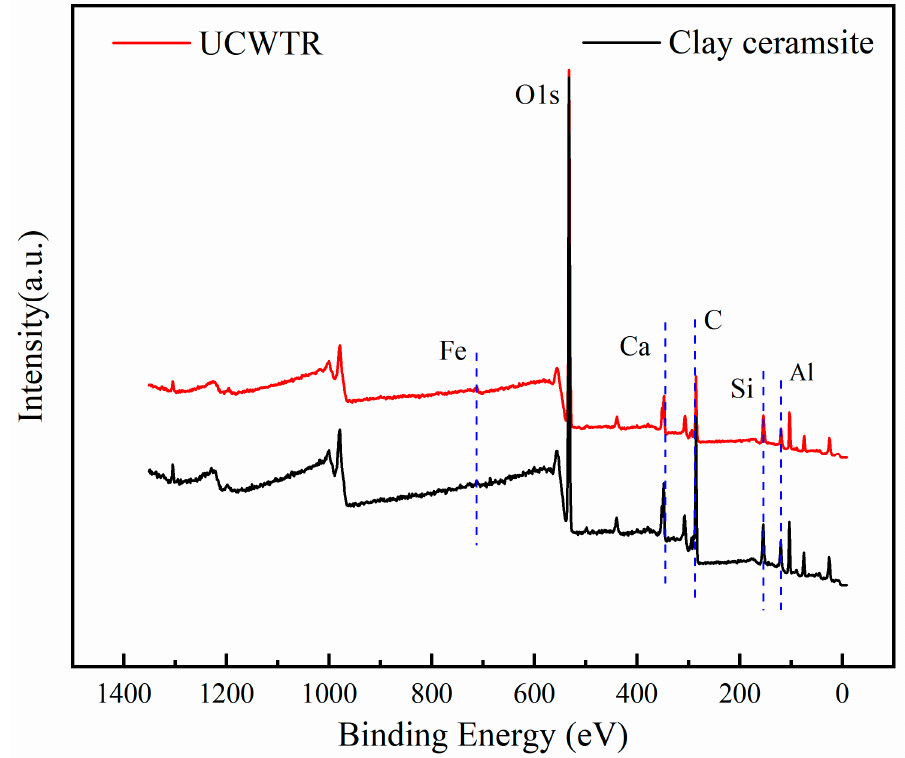
Figure 5. XPS spectra of CWs UCWTR and clay ceramsite.